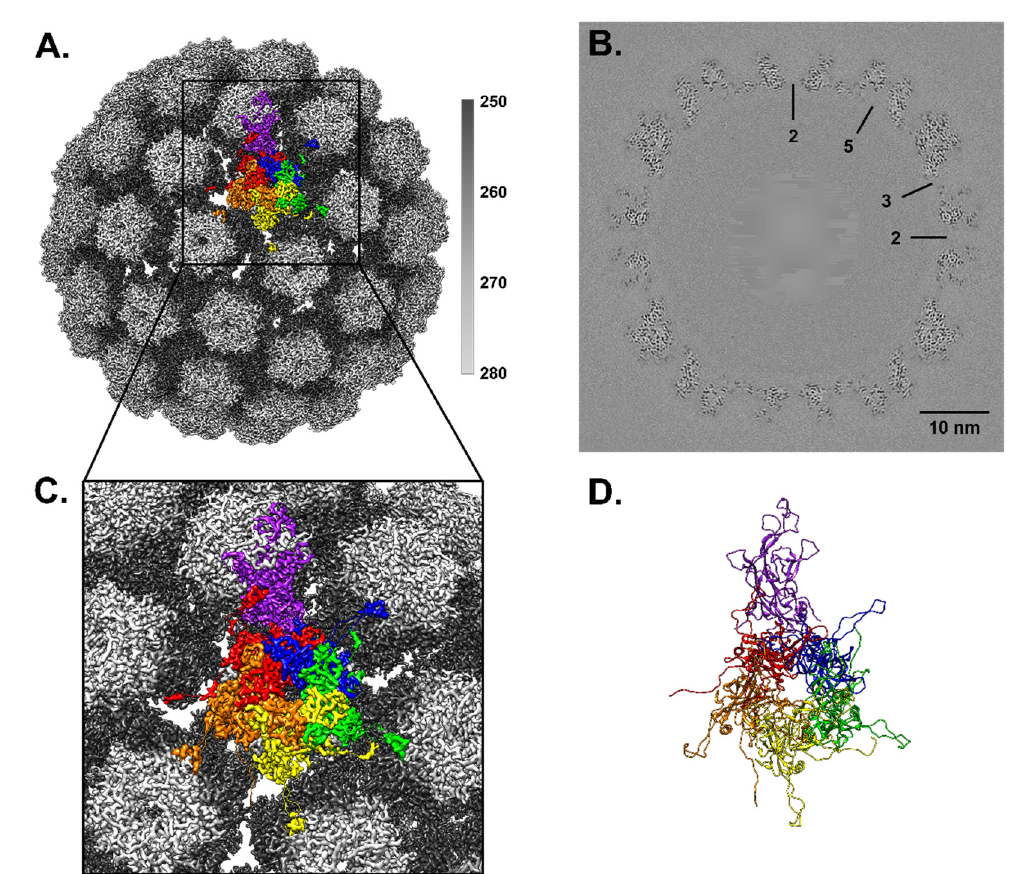
Figure 3. High resolution recombined map. ( A ) The high resolution recombined MmuPV1 map is surface rendered and colored radially (see key) with one copy of the asymmetric unit fit into the map and colored by chain using the same color code as Figure 2. (Chain A–F: purple, blue, green, yellow, orange, and red). ( B ) The high quality of the map is displayed in the central section with symmetry axes labeled. ( C ) Zoom view from panel A illustrates this first build of L1 proteins comprising the asymmetric unit. There is continuous density for all chains. ( D ) L1 protein ribbon rendering of the asymmetric unit.